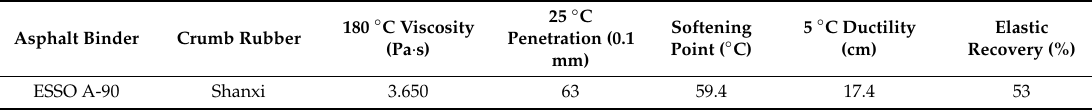
Table 9. Physical Properties of Asphalt